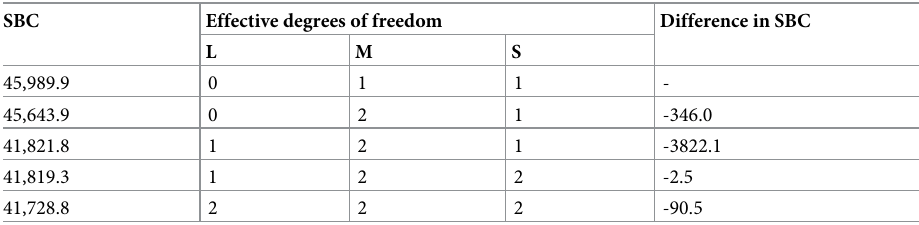
Table 1. Sequential optimisation process for the CCC-S (n = 6,459).